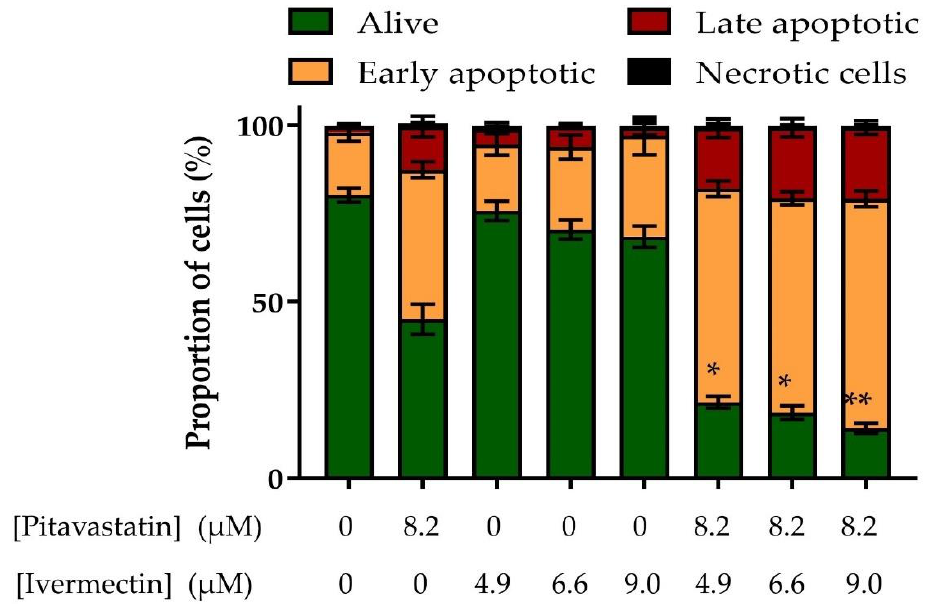
Figure 4. Evaluation of the combination of pitavastatin and ivermectin on annexin V/propidium iodide labelling. The effect of ivermectin combinations on annexin V/propidium iodide-staining. Cov-318 cells were treated with the indicated concentration of ivermectin, with/without pitavastatin (8.2 µ M) for 48 h; the cells were labelled with annexin V and propidium iodide and analysed by flow cytometry. The results are expressed as a fraction of the total number of cells analysed (mean ± SD, n = 3). The results were significantly different from those in cells treated with pitavastatin alone where indicated (*, p < 0.05, **, p < 0.01, paired t -test).